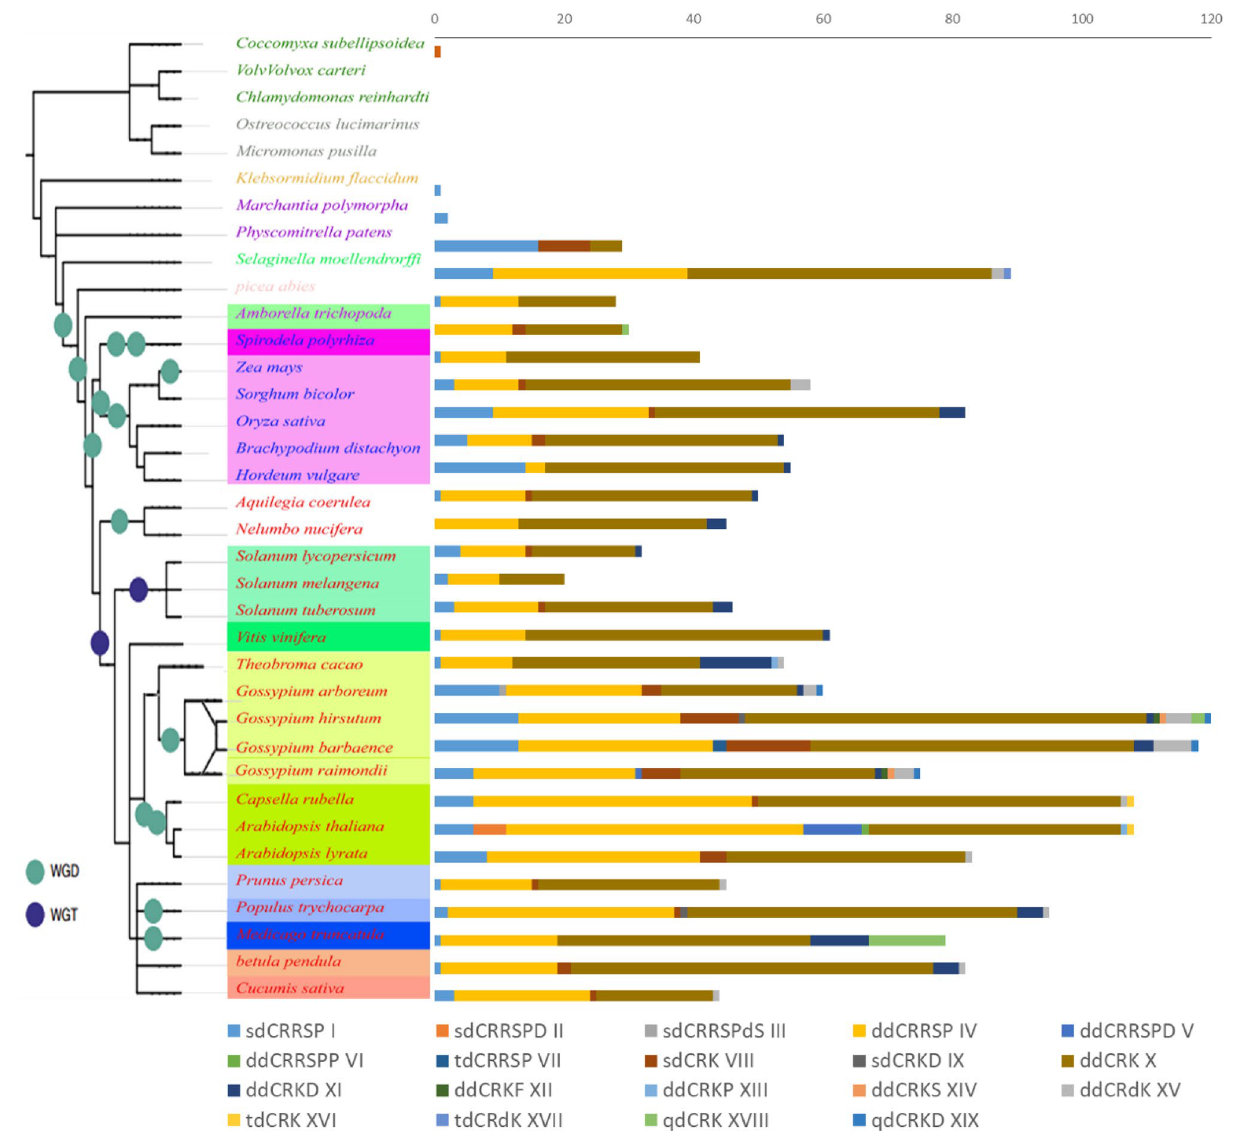
Figure 3. Land plants species phylogenetic tree with their total no. of CRKs and classes. The roman number are presenting classes based on 3rd classification